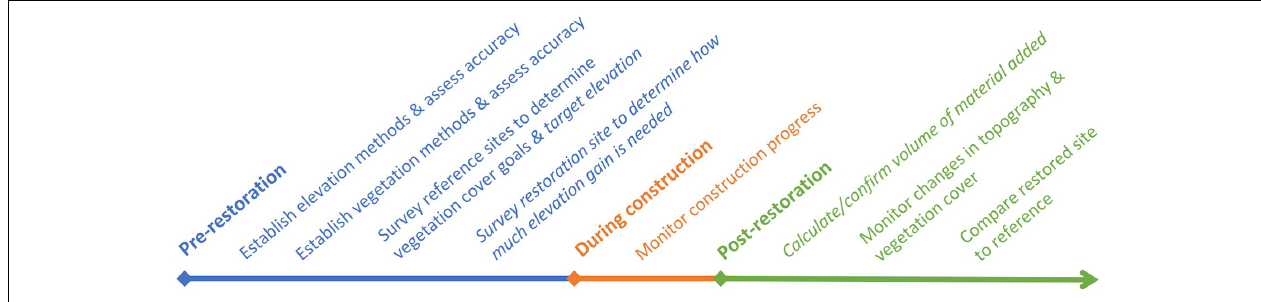
FIGURE 10 | Recommendations for timing of UAV monitoring, generally applicable to all restoration (regular text) and specific to sediment/soil addition projects (italic